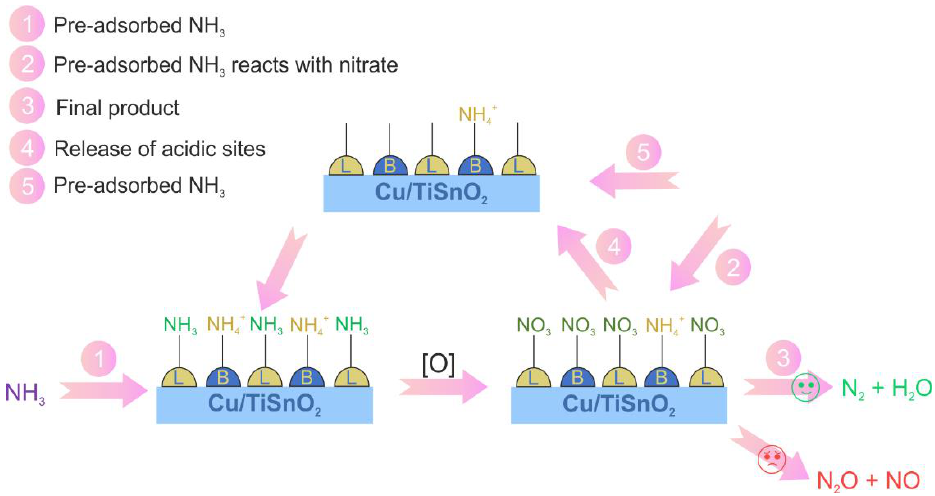
Figure 6. Reaction mechanism of NH 3 -SCO over Cu/TiSnO 2 . Reprinted from [85] with permission of Elsevier.